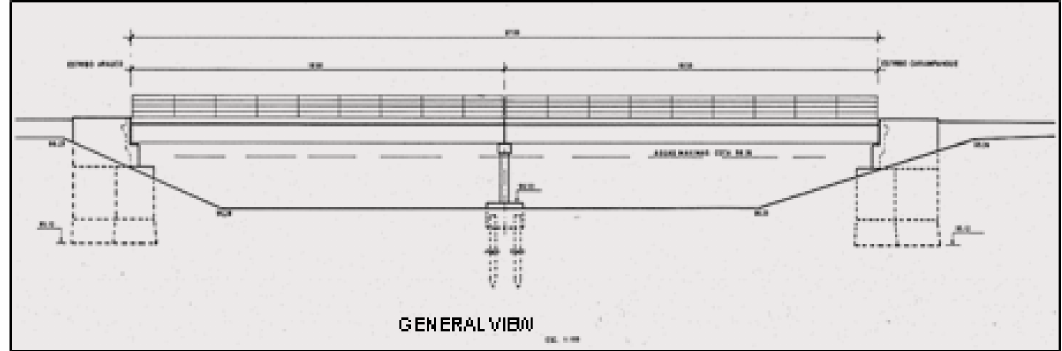
Figure 3. Original blueprint—Huillines Bridge No. 2.